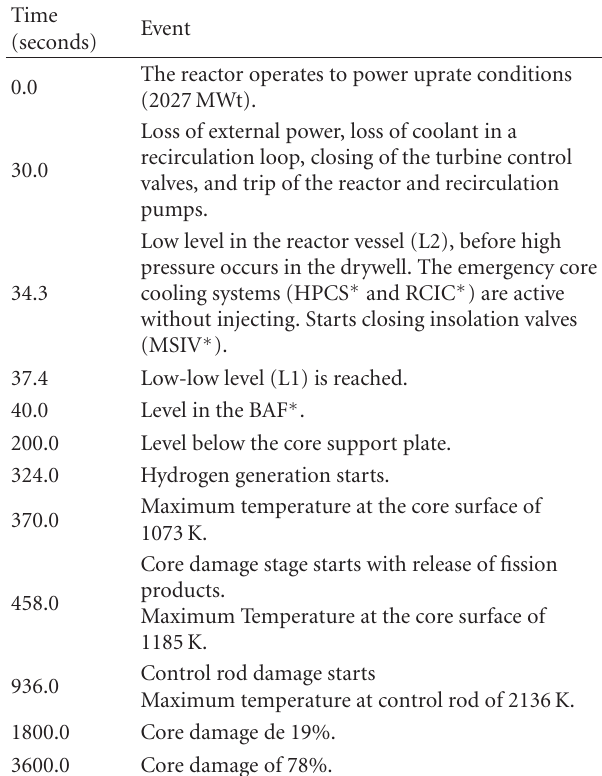
Table 1: Main sequence of events in a LOCA without cooling